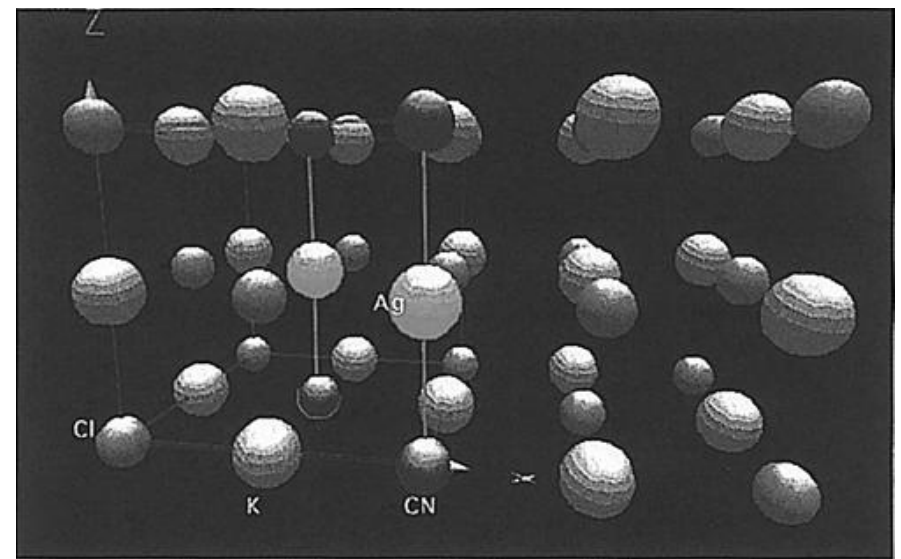
Figure 2. Structure of a unit cell of KCl with a defect created by doping two adjacent Ag(CN) 2− ions. In the defect, the Ag + and CN − ions are shown to occupy the K + and Cl − sites, respectively. (Reprinted with permission from [31]. Copyright 1998